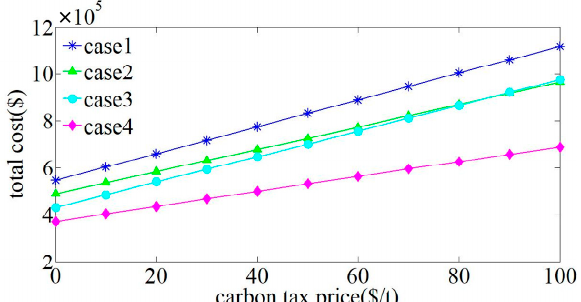
Figure 10. The total cost under different carbon tax prices in Cases 1–4. In the figure, the blue curve drawn by asterisk connection, the green curve drawn by triangle connection, the cyan curve drawn by circular connection and the purple curve drawn by diamond connection, respectively, represent the total cost under different carbon tax prices in Case 1, Case 2, Case 3 and Case 4.